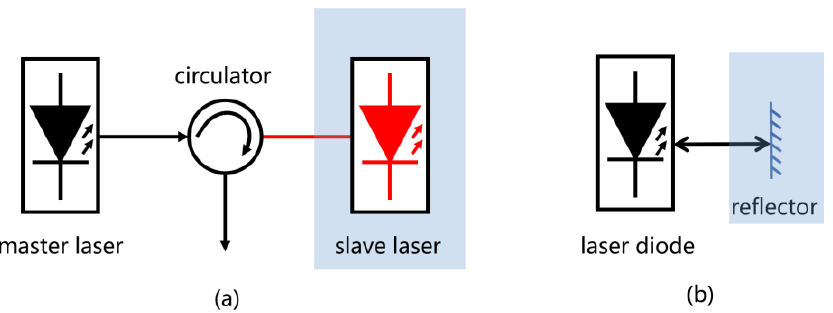
Figure 1. Schematic diagrams of the OIL technique. ( a ) External OIL configuration consists of master lasers and slave lasers. The master light can be injected into the slave laser and the output light can be blocked from the master laser via a circulator. ( b ) Self-injection-locking configuration consists of a reflector through which light can be partially fed back.